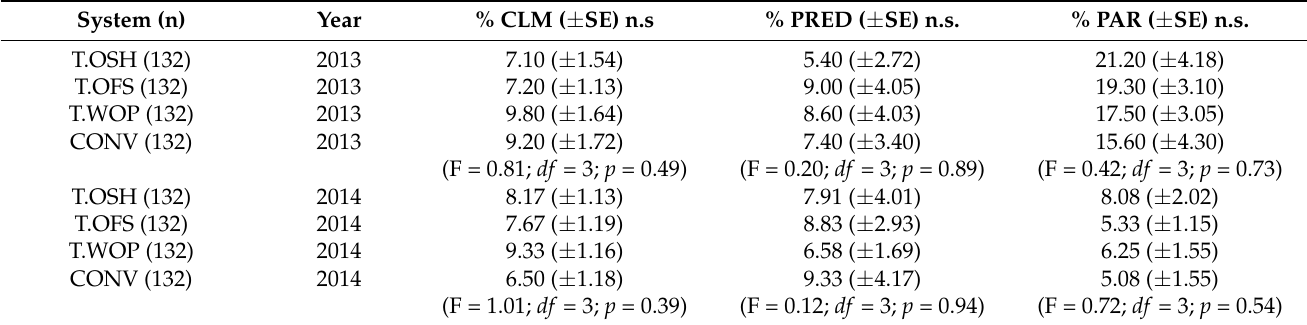
Table 3. The mean percentage of coffee leaf miner infestation (%CLM), predation (%PRED), and parasitism (%PAR) in conventional and three agroecological transitions systems of coffee plants (Coffea arabica ) within two consecutive years (2013 and 2014).